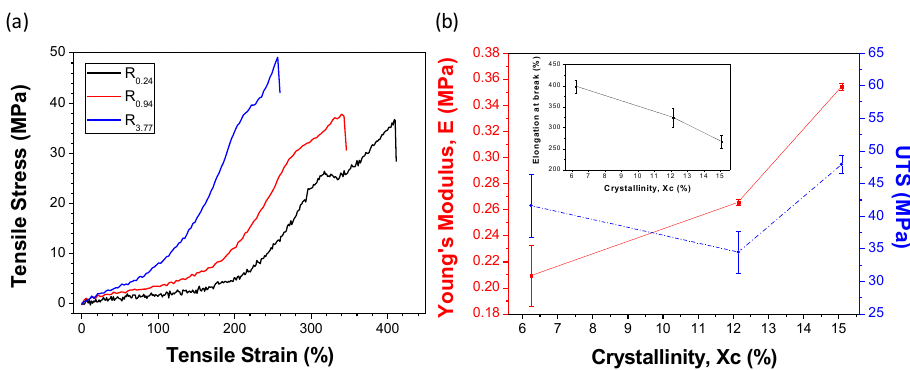
Figure 5. ( a ) Stress–strain curves for PLC rings with different melt-drawing speeds; ( b ) Relationship between Young ׳ s modulus, UTS, and maximum elongation with crystallinity of PLC.